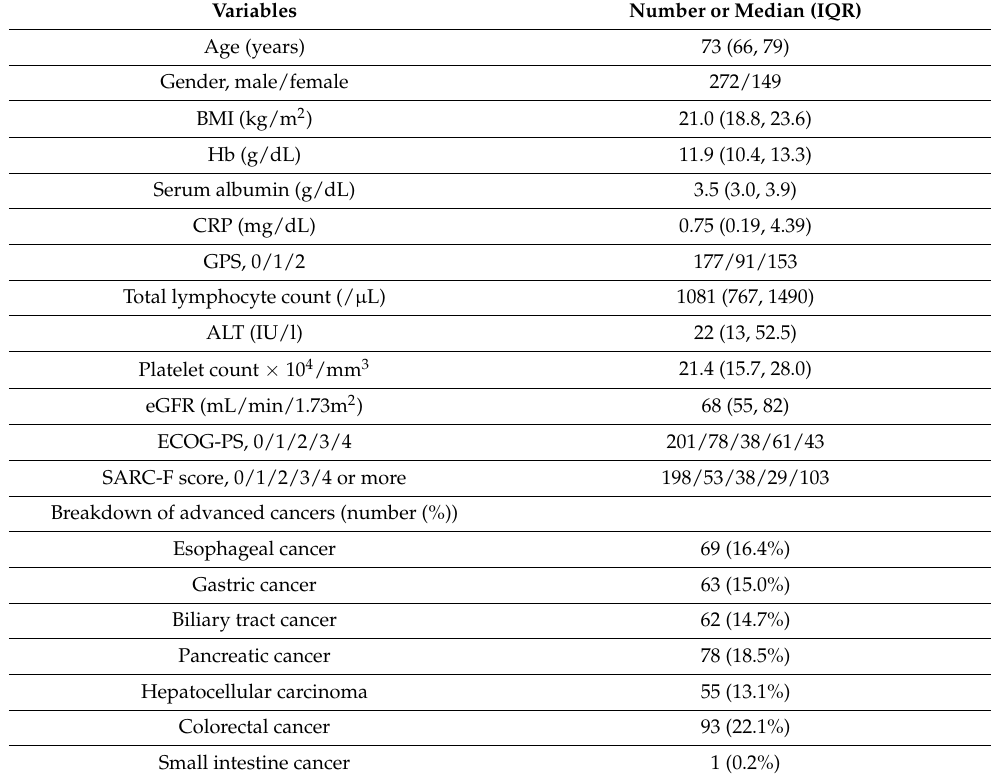
Table 1. Baseline